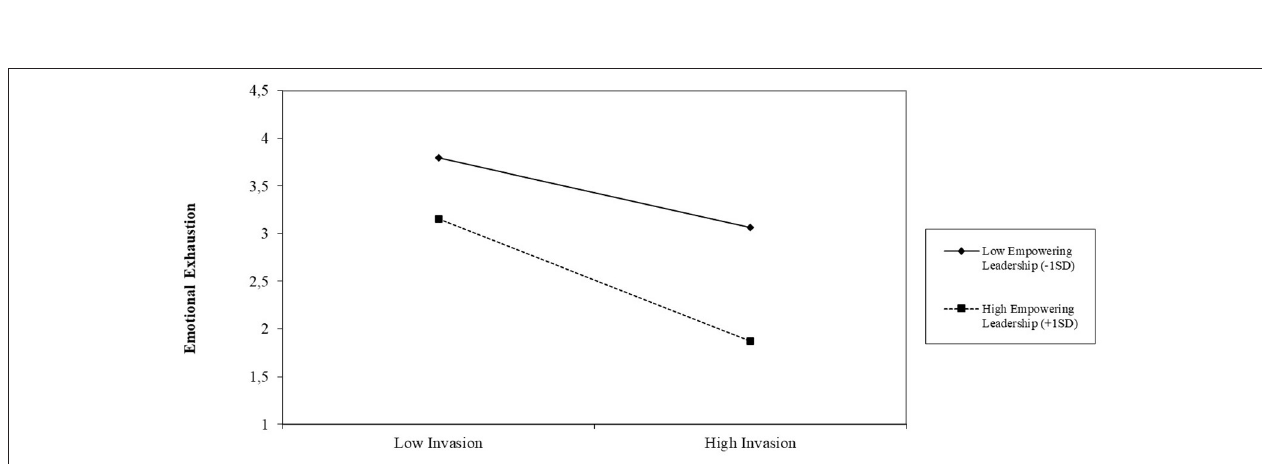
FIGURE 3 | Interaction plot for the relation between techno-complexity and emotional exhaustion under high ( + 1SD) and low ( − 1SD) empowering